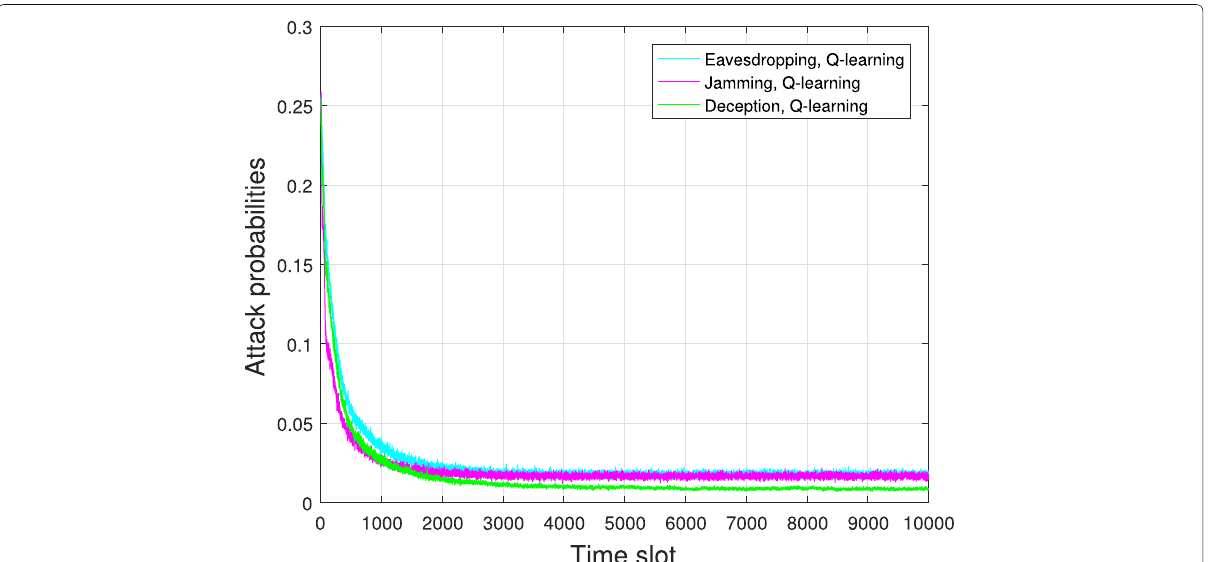
Fig. 5 The average attack probabilities of the power allocation algorithm with { ν 2 , μ 2 , λ 2 } = { 1.2,0.5,2 }